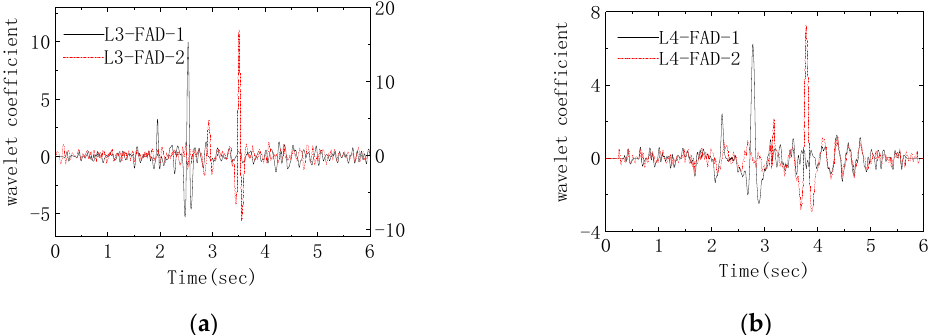
Figure 14. Wavelet coefficients for multiple-presence loading event: ( a ) Truck B in Lane 3; ( b ) Truck A in Lane 4.